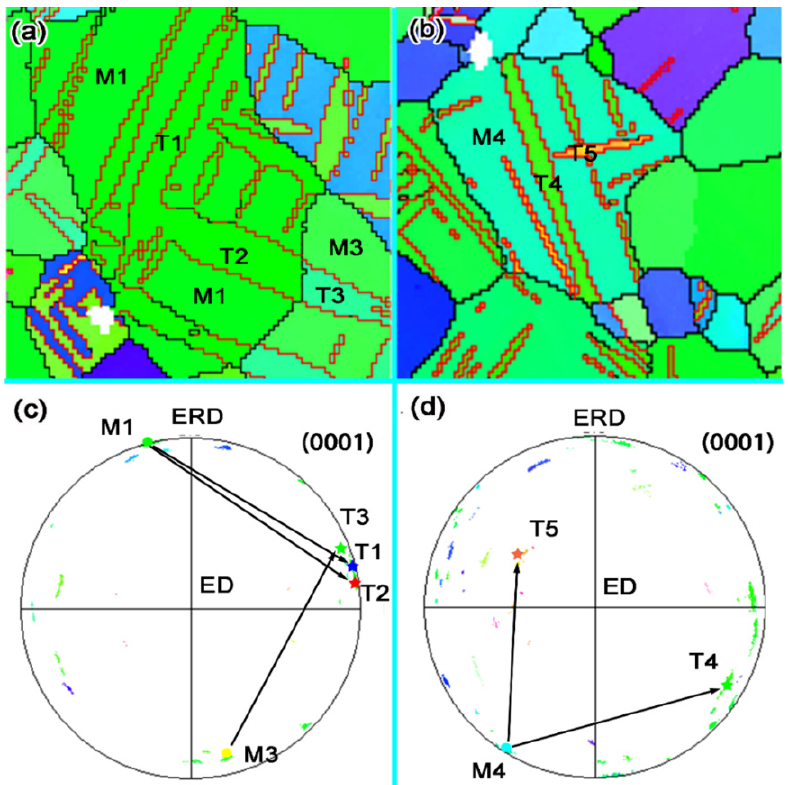
Figure 4. ( a , b ) Typical inverse pole figure EBSD maps showing the macrostructure feature of grain 1 and grain 4 in Figures 3. ( c , d ) The corresponding pole figures of regions shown in Figure 4c,d respectively.